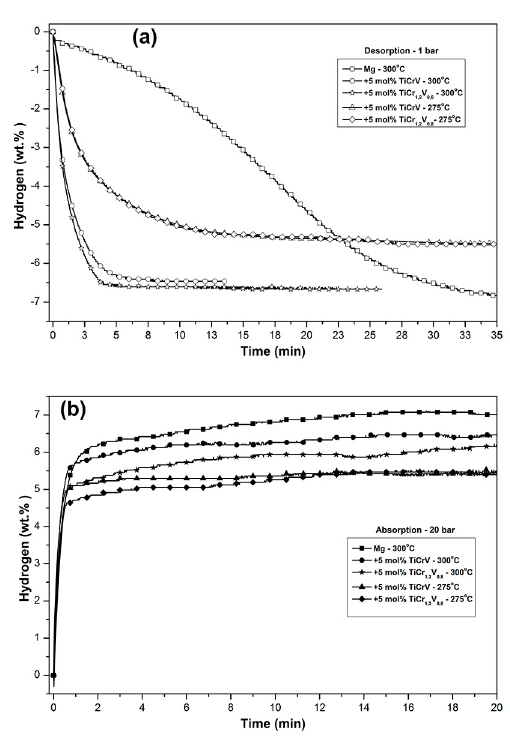
Figure 7. (a) Desorption kinetics at 275 o C and 300 o C for the pure Mg and for the nanocomposites containing 5 mol% of TiCrV and TiCr V under 1 bar of hydrogen pressure. (b) Absorption kinetics 1,2 0,8 at 275 o C and 300 o C for the pure Mg and for the nanocomposites containing 5 mol% of TiCrV and